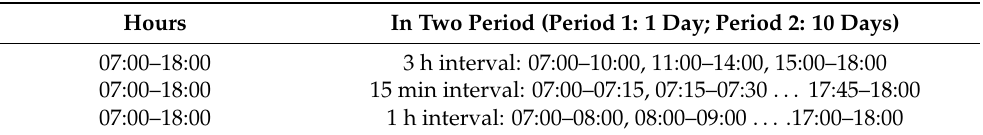
Table 6. Analysis periods.